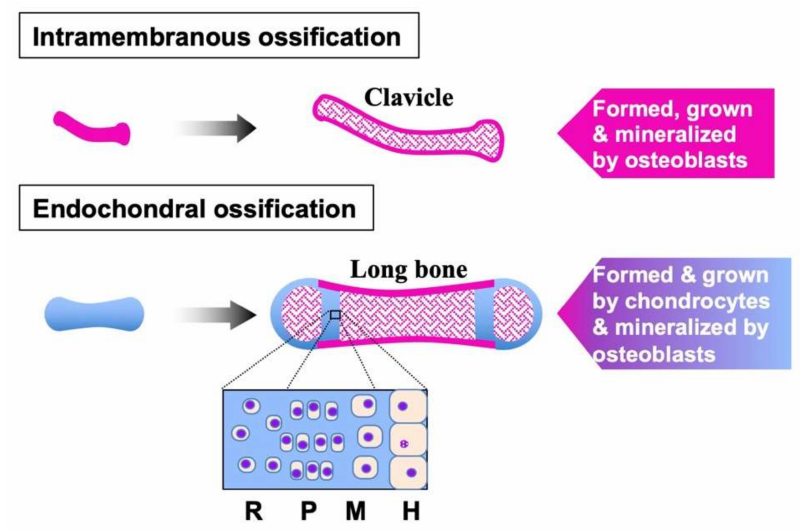
Figure 1. Two major modes of the ossification that constructs the human skeleton. Clavicle and cranial bones are formed through intramembranous ossification, where osteoblasts create the prototype (left) and grow the bone (shown in pink). Most of the other bones are initially formed by chondrocytes as cartilage anlagen (left, shown in light blue), and chondrocytes grow them at the growth plate inside and develop articular cartilage at the epiphysis. Along with bone growth, ECM is mineralized by osteoblasts. In the growth plate, chondrocytes follow a serial differentiation process from resting (R), proliferation (P), mature (M), and hypertrophic (H) stages towards ossification